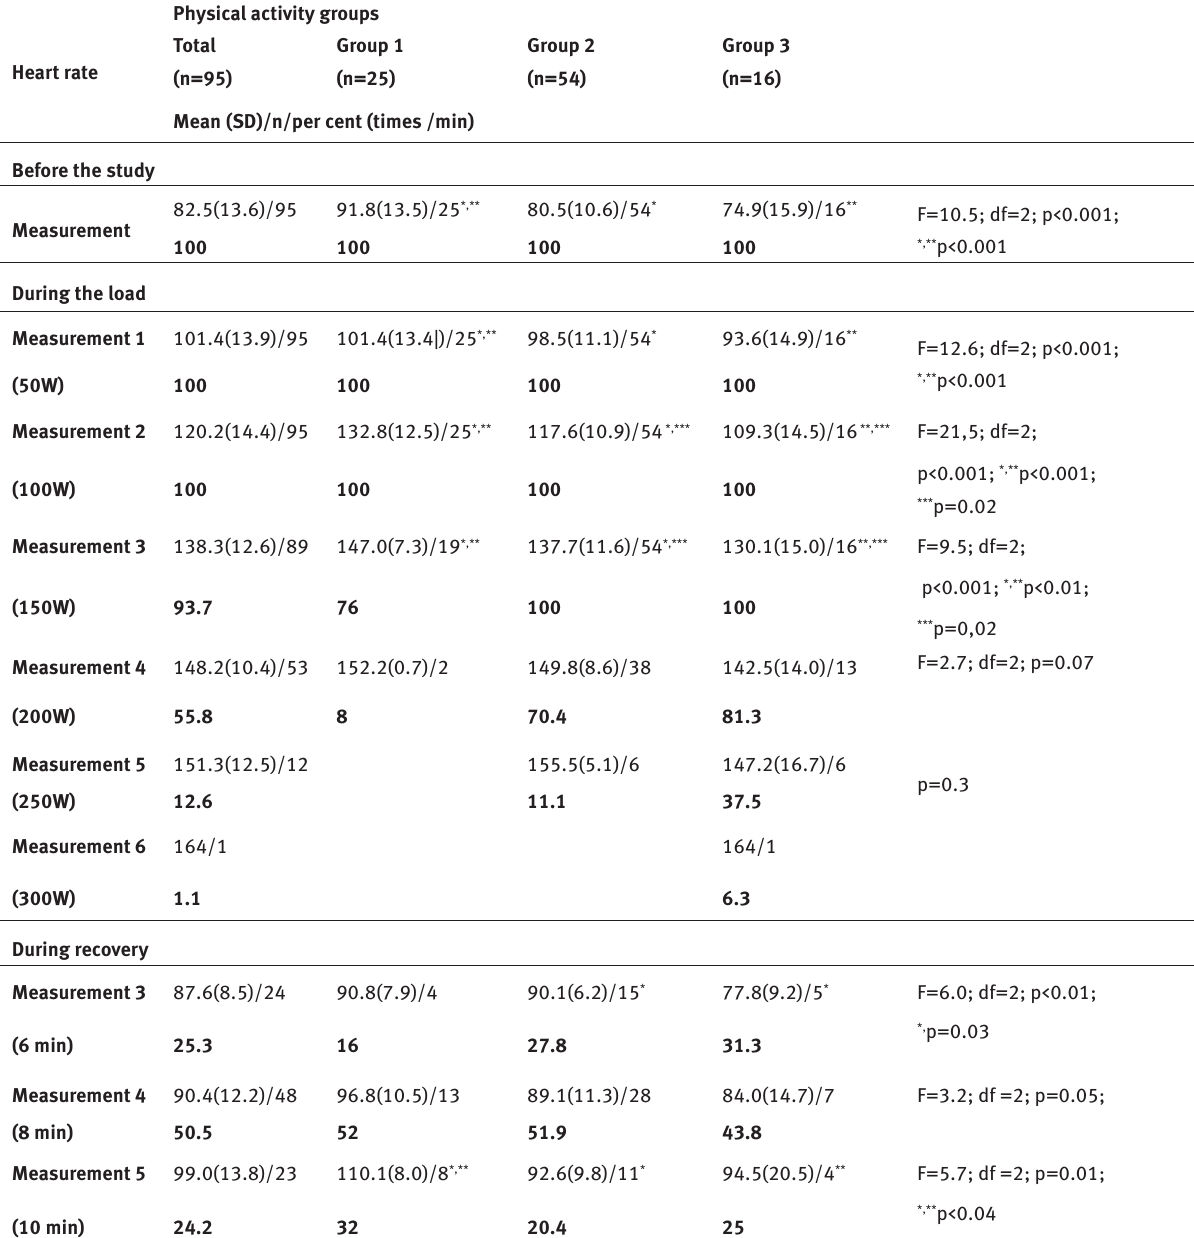
Table 2: Heart rate of subjects before the study and its changes during the physical load and recovery taking into account physical activity groups